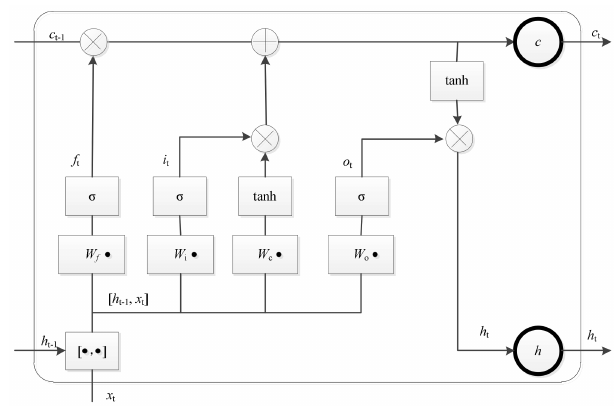
Figure 1. The structure of a long short-term memory (LSTM) block.